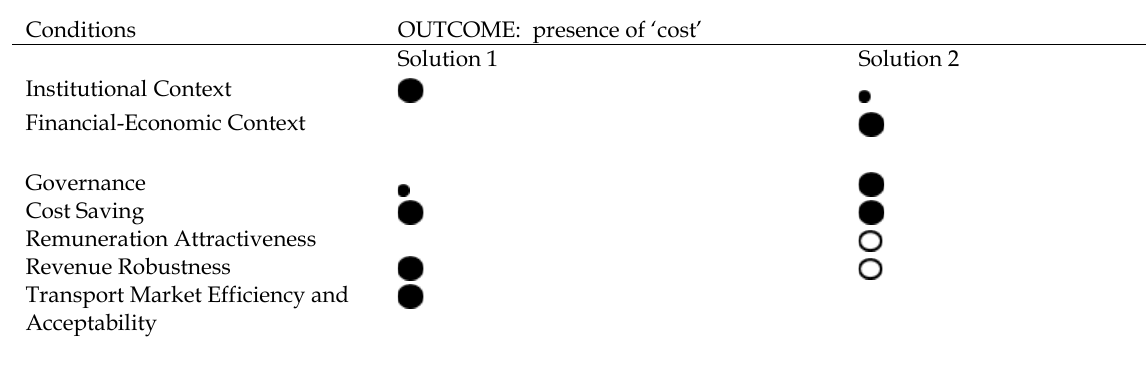
Sufficiency analysis of projects on cost (cut-off: 0.75)